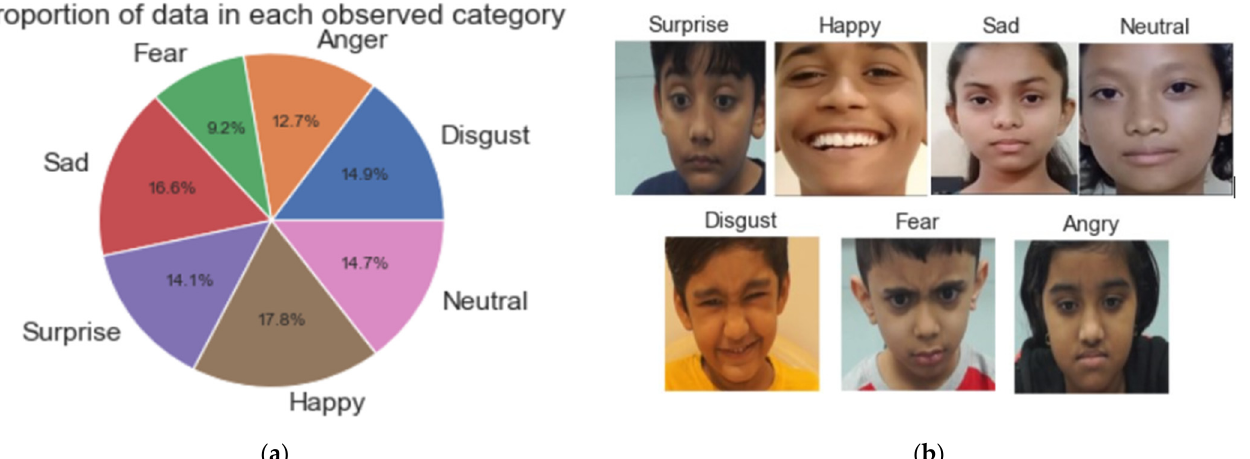
Figure 5. YOLOv3 simultaneous face detection and cropping.